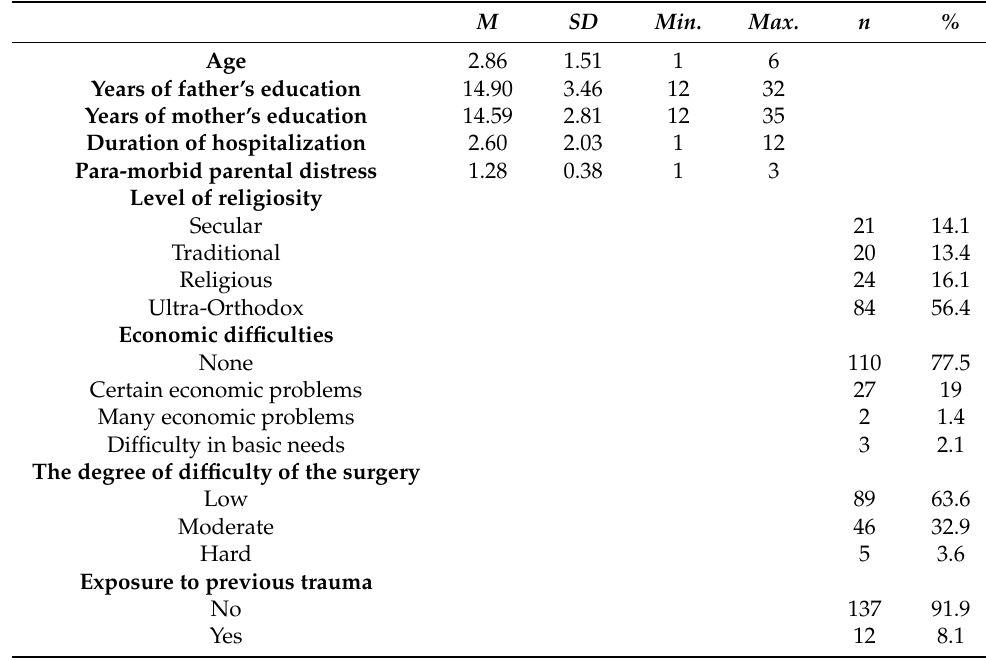
Table 1. Demographic and clinical background characteristics of the sample (N =